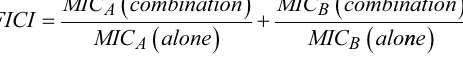
FICI ≤ 0.5 indicated synergy, 0.5 < FICI ≤ 4 indicated no